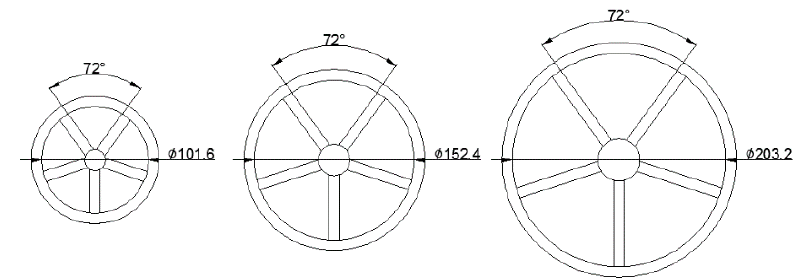
Figure 2. Basic five-spoke stop valves.